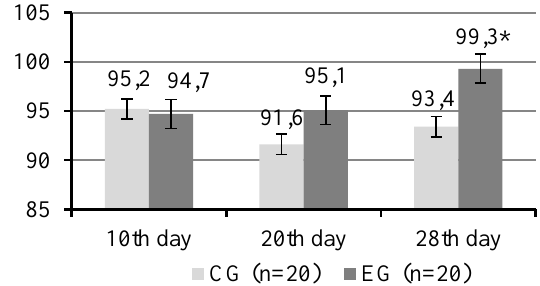
Fig. 2. Hemoglobin blood level in suckling piglets